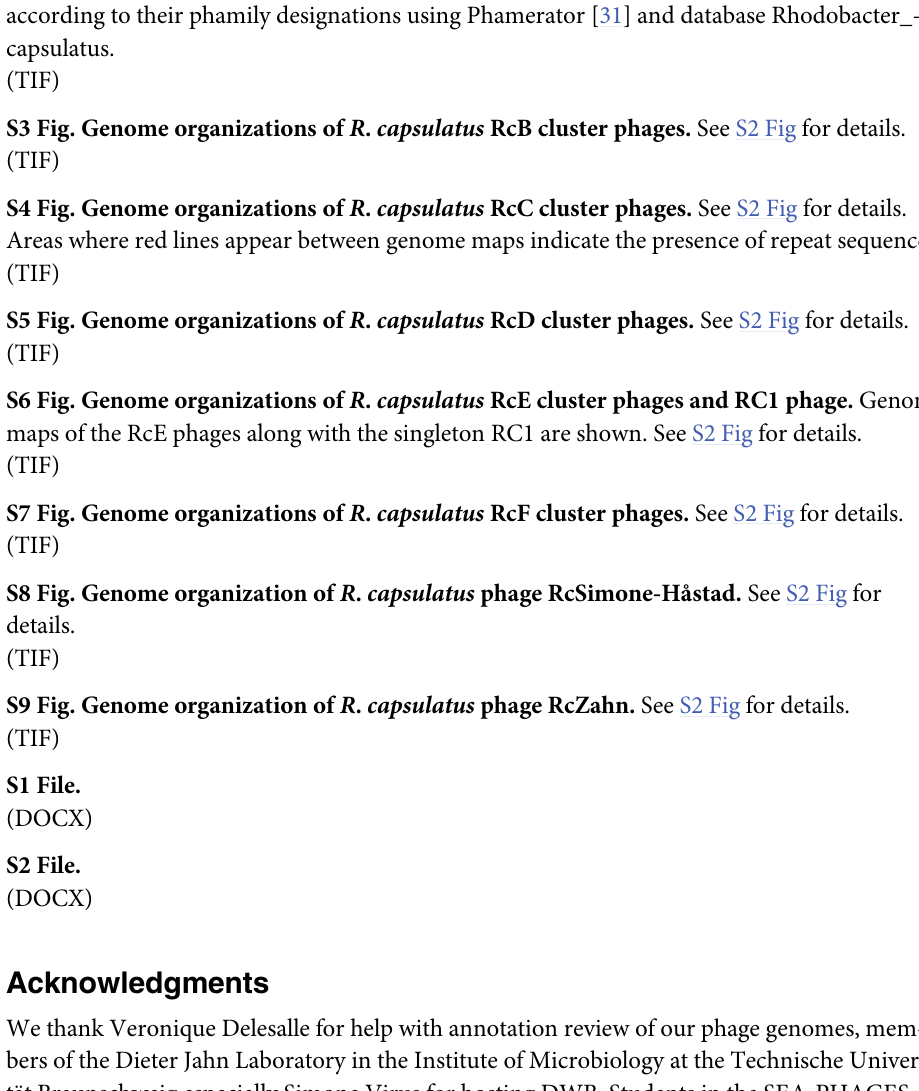
S1 Fig. Dotplot comparison of catenated genomes. A dotplot comparison of the catenated genomes against themselves was created using Gepard [1]. Areas of clustering are color-coded to match the cluster colors on Fig 2. S2 Fig. Genome organizations of R . capsulatus RcA cluster phages. Genome maps of the RcA phages are shown. Pairwise nucleotide sequence similarities are displayed with spectrum- coloring between genomes, with violet representing greatest similarity and red the least simi- lar, above a threshold E value of 10 − 3 . Genes are represented as boxes above or below the genomes reflecting rightwards- and leftwards-transcription respectively. Genes are colored according to their phamily designations using Phamerator [31] and database Rhodobacter_- capsulatus. S3 Fig. Genome organizations of R . capsulatus RcB cluster phages. See S2 Fig for details. S4 Fig. Genome organizations of R . capsulatus RcC cluster phages. See S2 Fig for details. Areas where red lines appear between genome maps indicate the presence of repeat sequences. S5 Fig. Genome organizations of R . capsulatus RcD cluster phages. See S2 Fig for details. S6 Fig. Genome organizations of R . capsulatus RcE cluster phages and RC1 phage. Genome maps of the RcE phages along with the singleton RC1 are shown. See S2 Fig for details. S7 Fig. Genome organizations of R . capsulatus RcF cluster phages. See S2 Fig for details. S8 Fig. Genome organization of R . capsulatus phage RcSimone-H å stad. See S2 Fig for details. S9 Fig. Genome organization of R . capsulatus phage RcZahn. See S2 Fig for